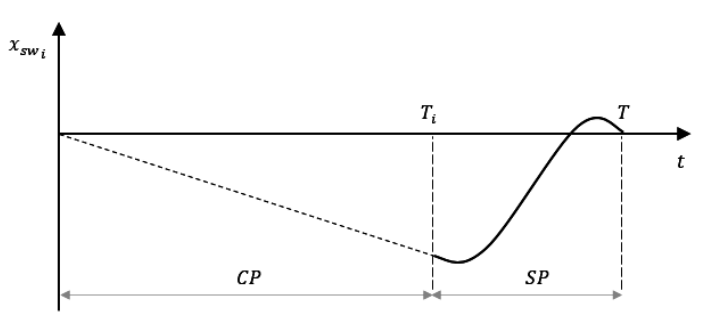
Figure 6. An example of the time history of 𝑥 (cid:3046)(cid:3050)(cid:3036) of the leg.